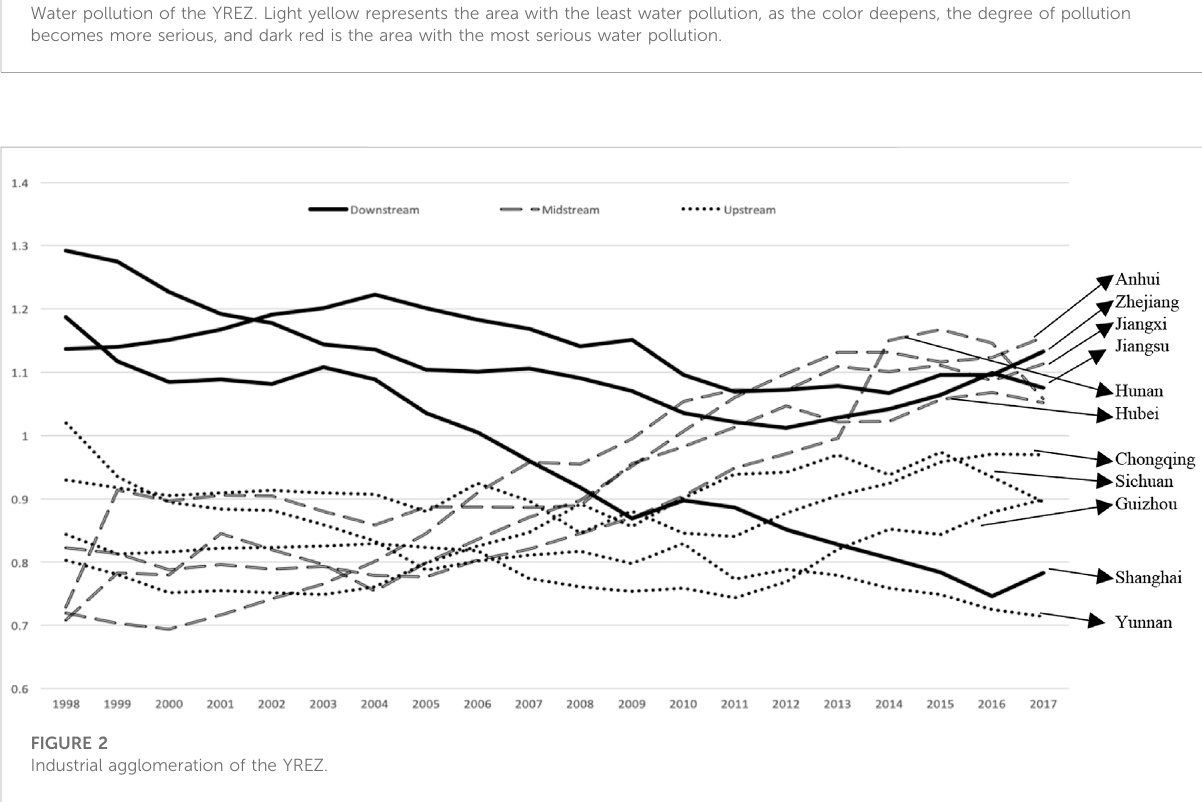
FIGURE 2 Industrial agglomeration of the